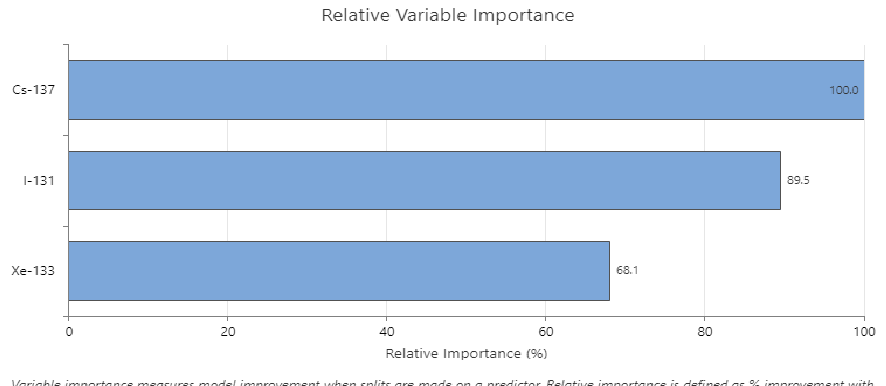
Figure 4. Graph showing relative importance of predictors April (spring).